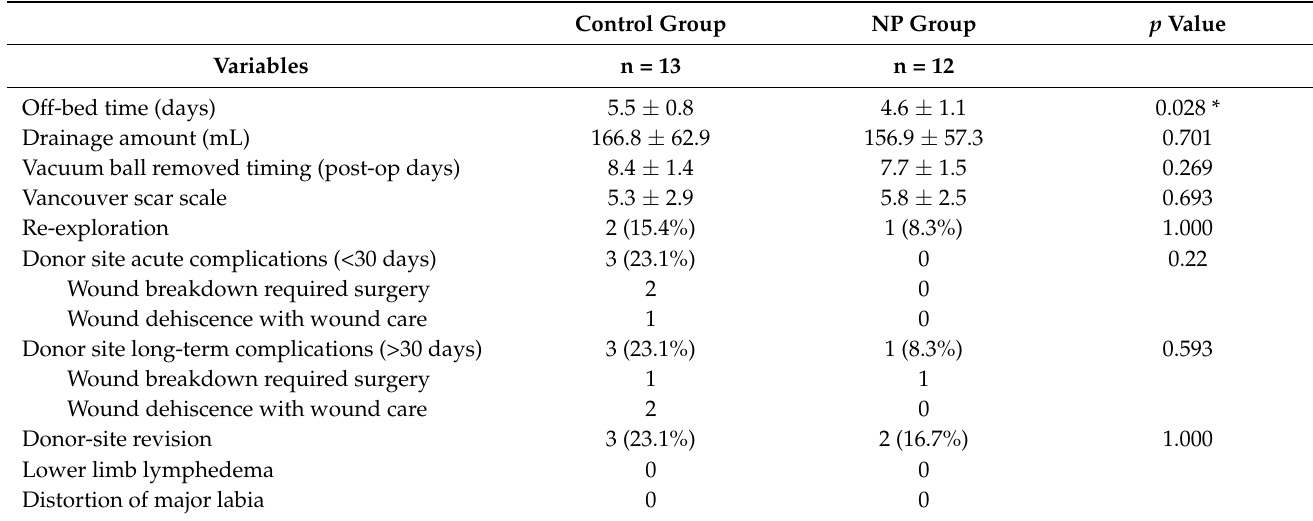
Table 5. Comparative results between control and negative-pressure wound therapy